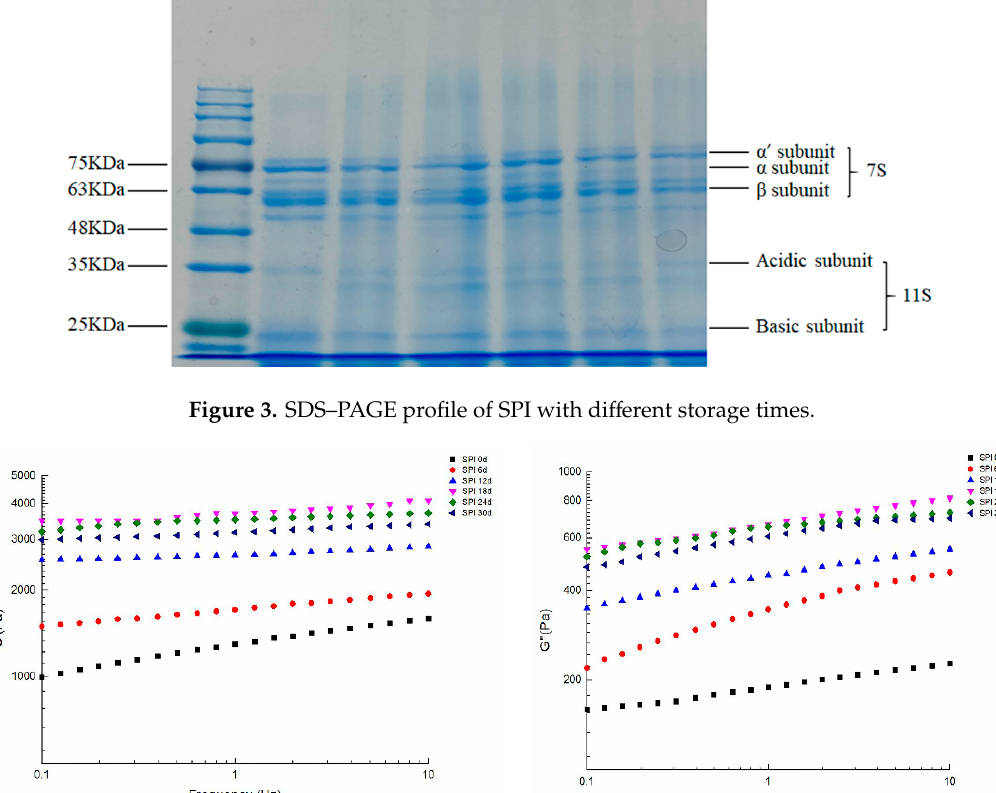
Figure 4. Frequency sweep the G ′ ( a ) and G ′′ ( b ) of Chiba tofu with different storage times.